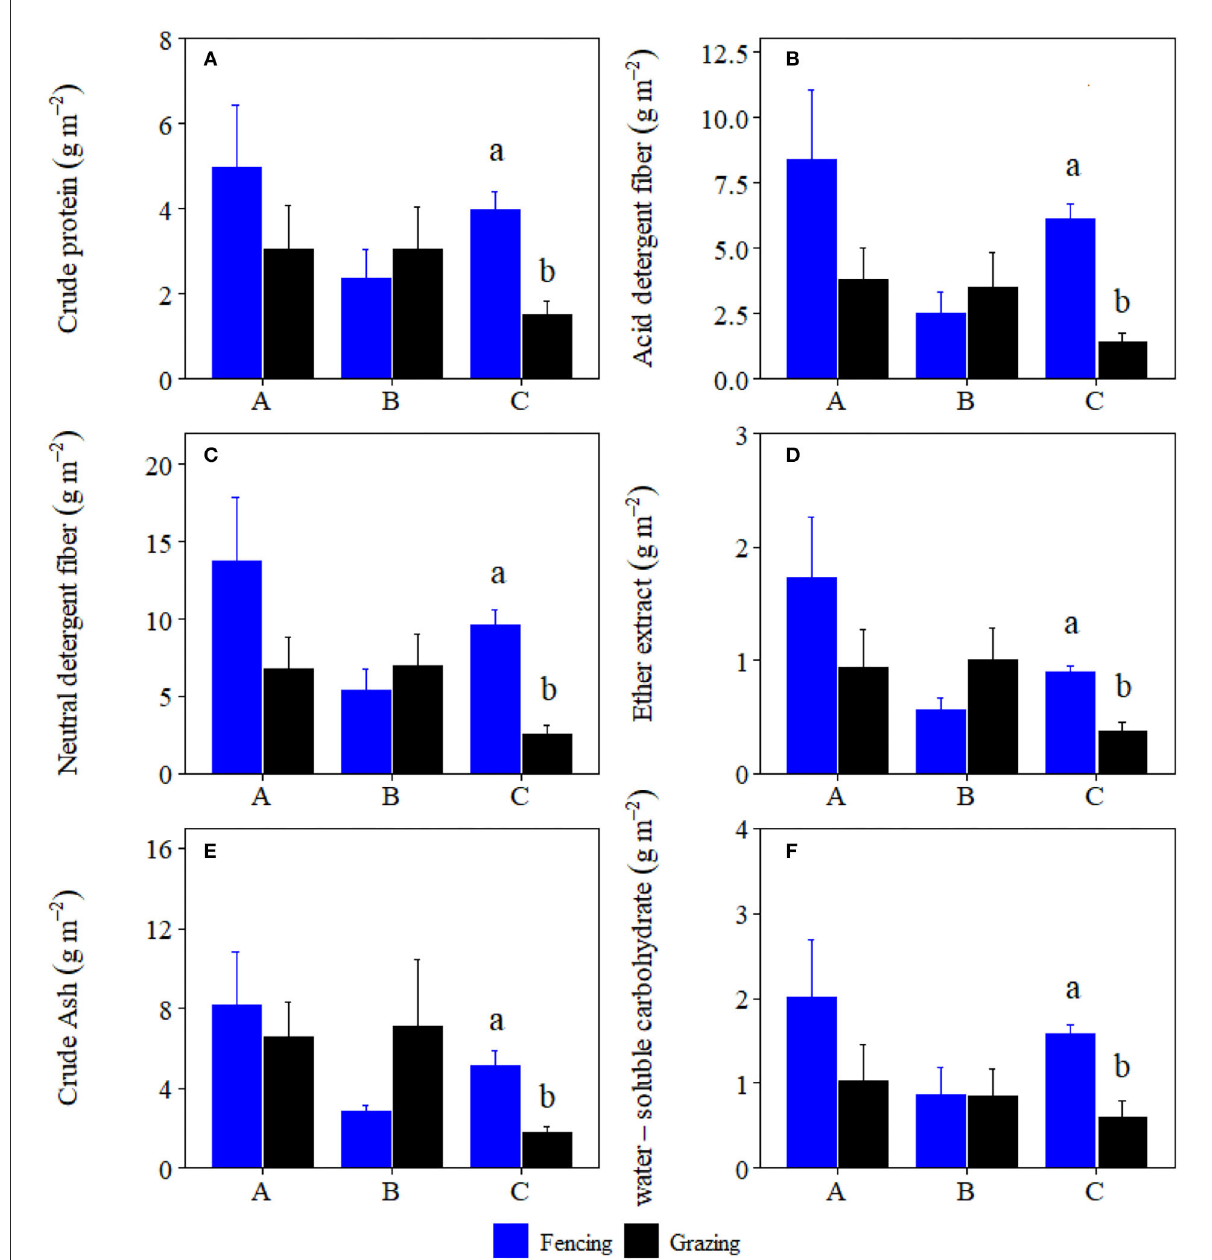
FIGURE2 Comparisons of forbs (A) crude protein, (B) acid detergent fiber, (C) neutral detergent fiber, (D) ether extract, (E) crude ash, and (F) water-soluble carbohydrate storages (mean ± SE) between the fencing and grazing conditions in three alpine grasslands located at site A–C, respectively. Different letters indicated significant difference for nutrition storages between the fencing and grazing conditions at p < 0.05